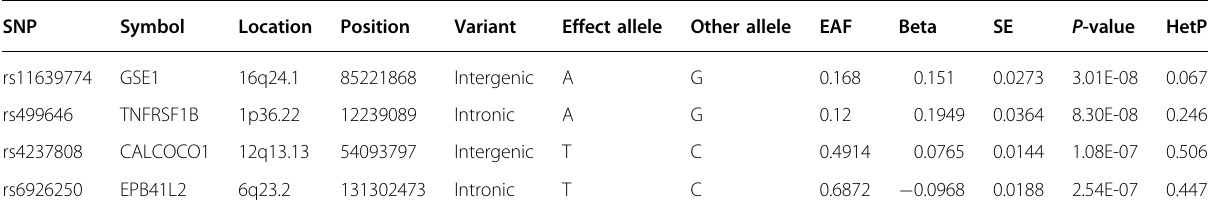
Table 2 Top SNPs associated with tardive dyskinesia. SNP